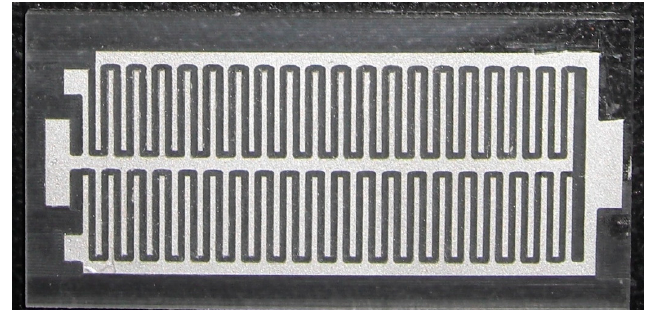
Figure 5. The pattern of the silver seed layer.